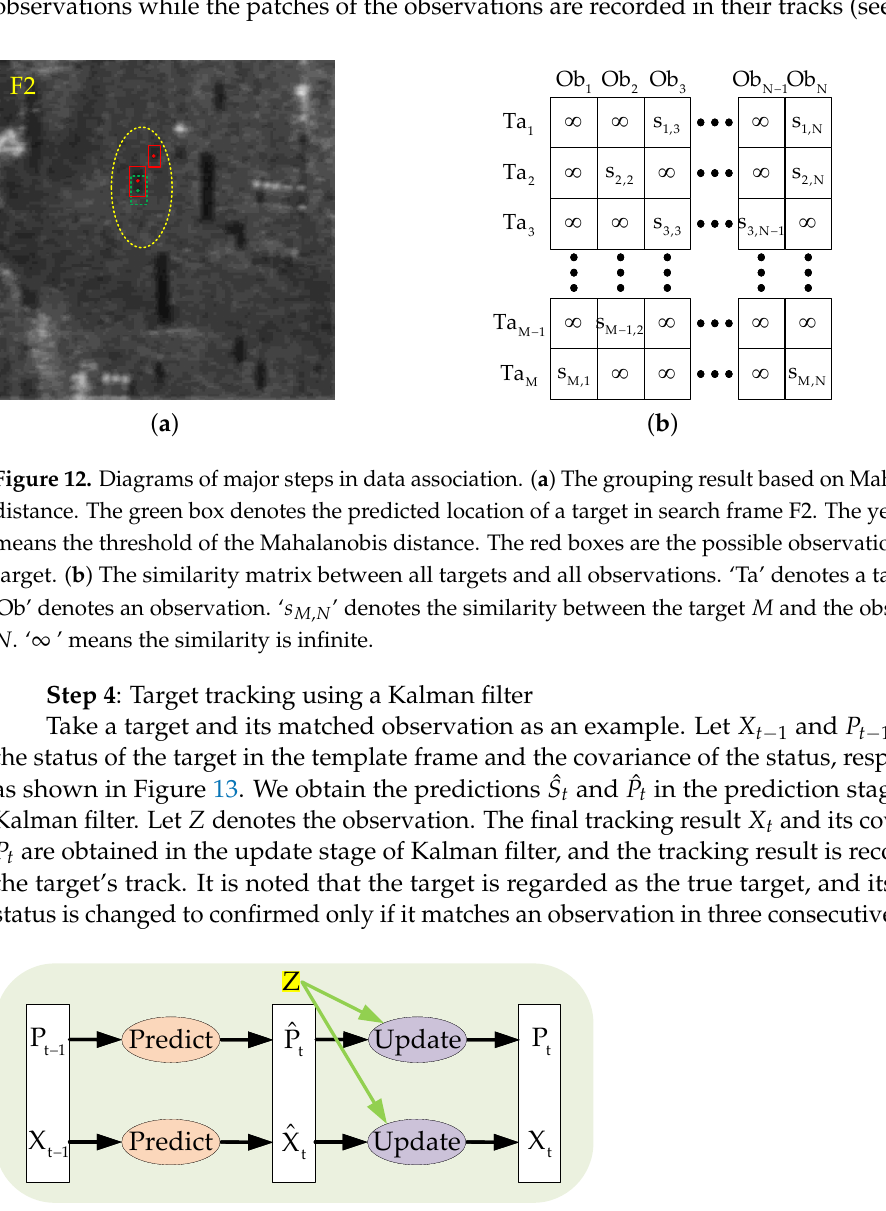
Figure 13. The process of Kalman